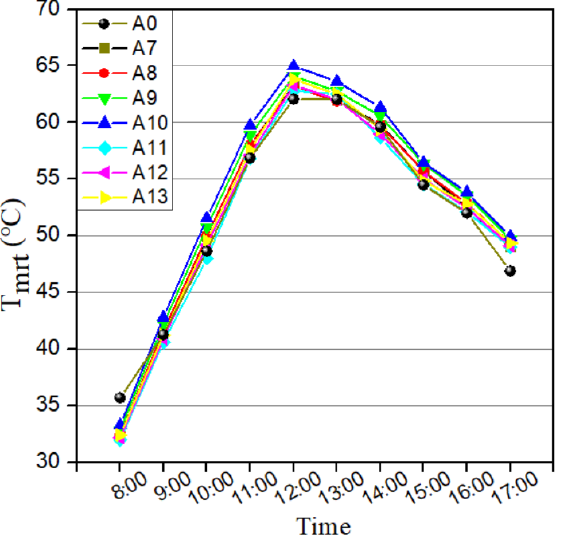
Figure 17. T mrt of the base case and cases with different surface albedo values.